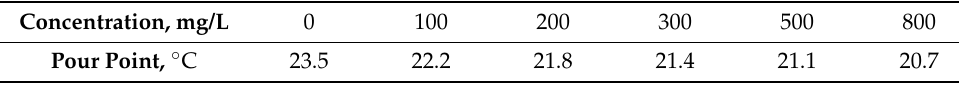
Figure 4. Effect of diesel-pyridine solvent blends on the viscosity of oil samples. Table 2. Effect of diesel-pyridine solvent blends on the pour point of oil samples.